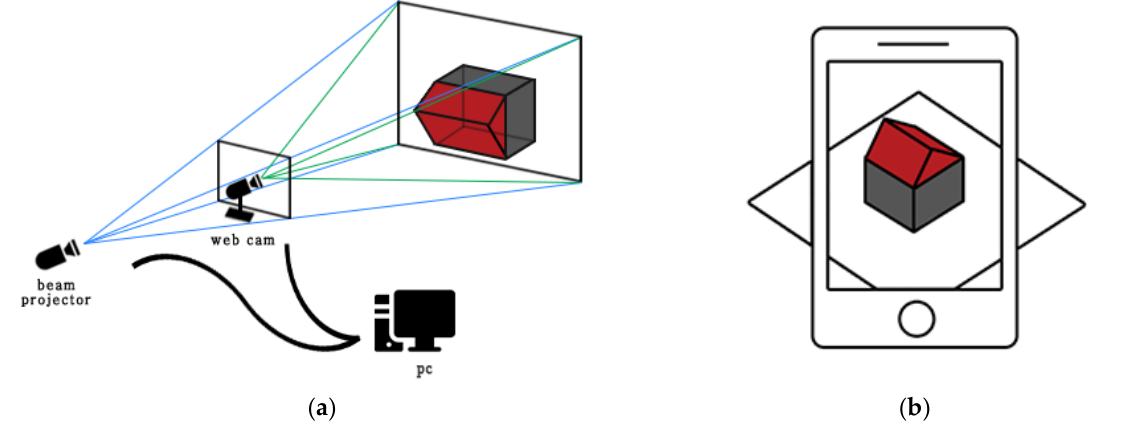
Figure 9. ( a ) Visualization with beam projector AR; ( b ) visualization with portable device AR. Note that portable device AR can change the viewpoint by moving the phone to other